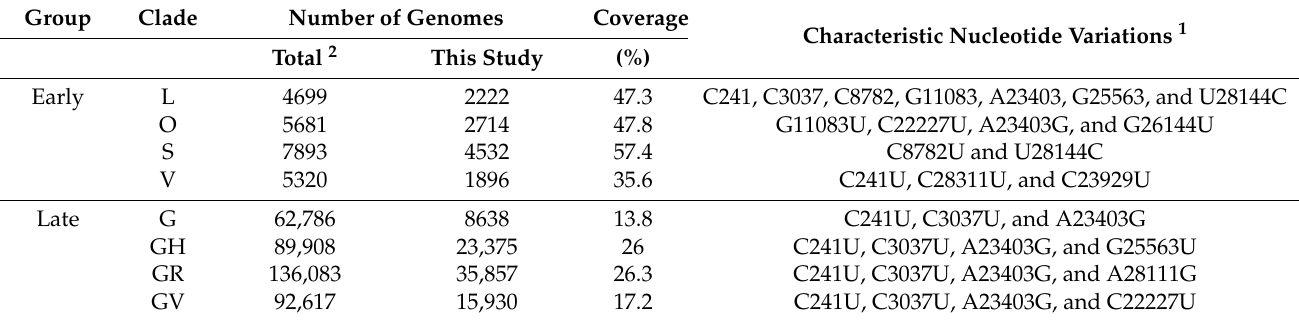
Table 1. Number of genomes used in the study and their phylogenetic